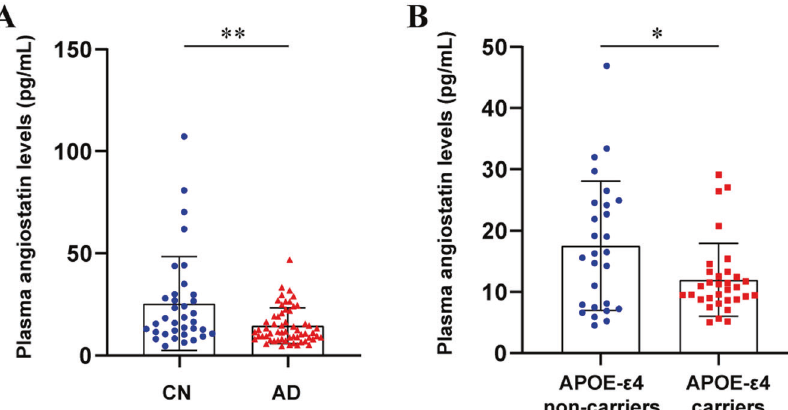
Fig. 1 Comparison of plasma angiostatin levels between different groups. Comparison of plasma angiostatin levels between the cognitively normal controls (CN) and PiB-PET + AD dementia patients ( A ). Comparison of the plasma angiostatin levels between APOE- ε 4 carriers and noncarriers among the PiB-PET + AD dementia patients ( B ).